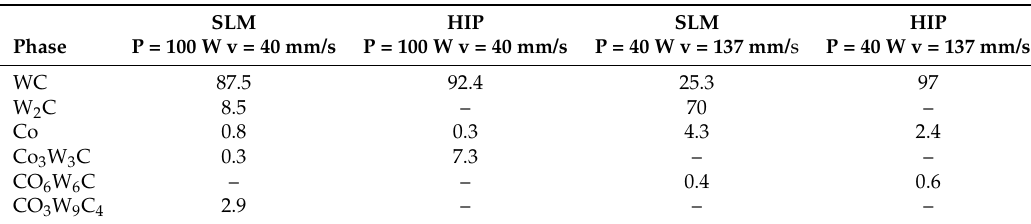
Table 3. Calculated volume fractions of phases in specimens made at low and high VED prior to and after